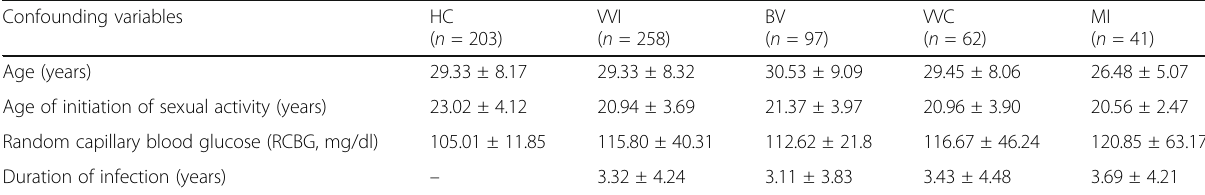
Table 1 Confounding parameters of study populations Confounding